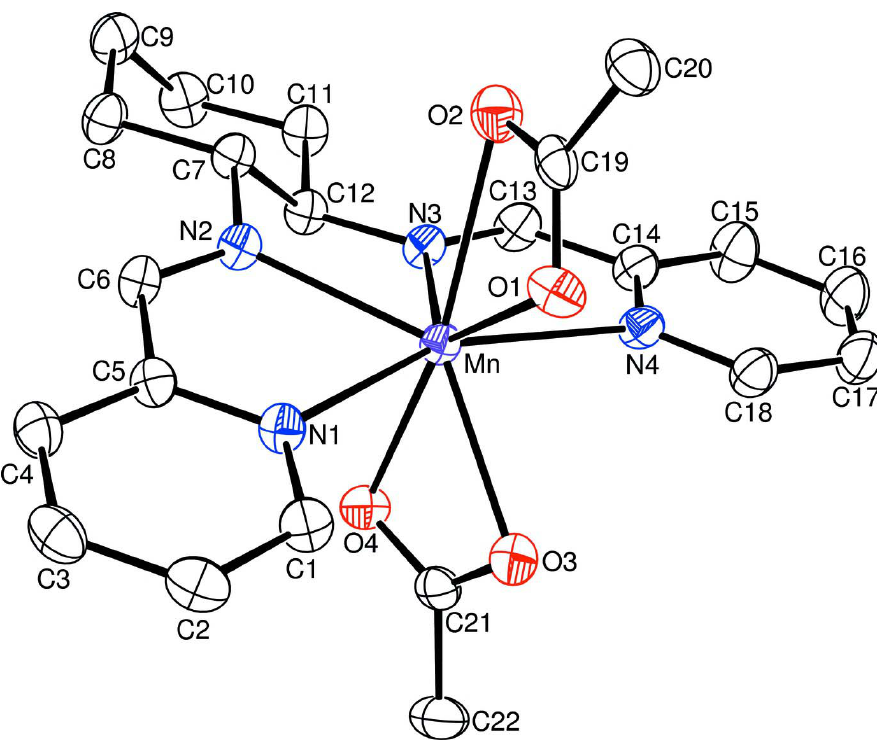
Figure 1 The structure of the title compound with the numbering scheme. Displacement ellipsoids are drawn at the 30% probability level. H atoms and the solvent H